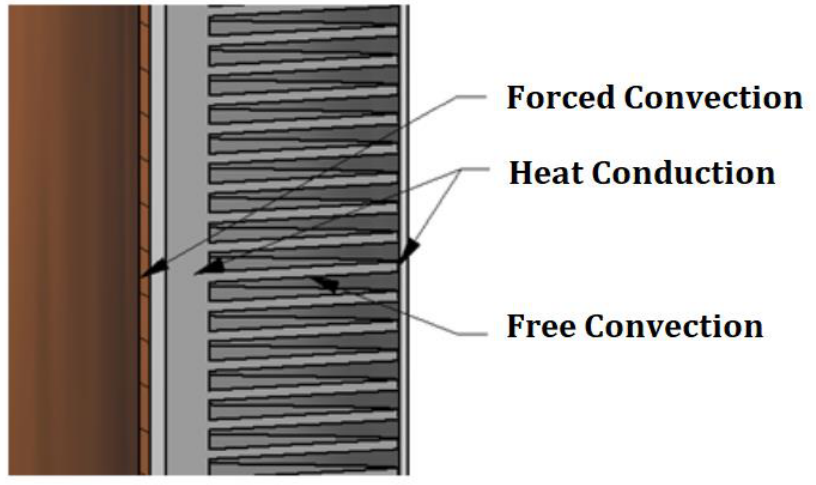
Figure 9. The heat exchange simulation system: 1—copper tube, 28 or 35 mm in diameter, 2—finned tube cut in half, 3—thin layer precisely filling the space resulting from the difference between the diameters of tube 1 and 2, 4—a space cut in the fins for placing the thermostat sensor, 5—1-mm thick aluminium sheet bent to contact with the fins, 6—heater bent to contact with the sheet surface, and 7—brass joint with an inch screw thread.